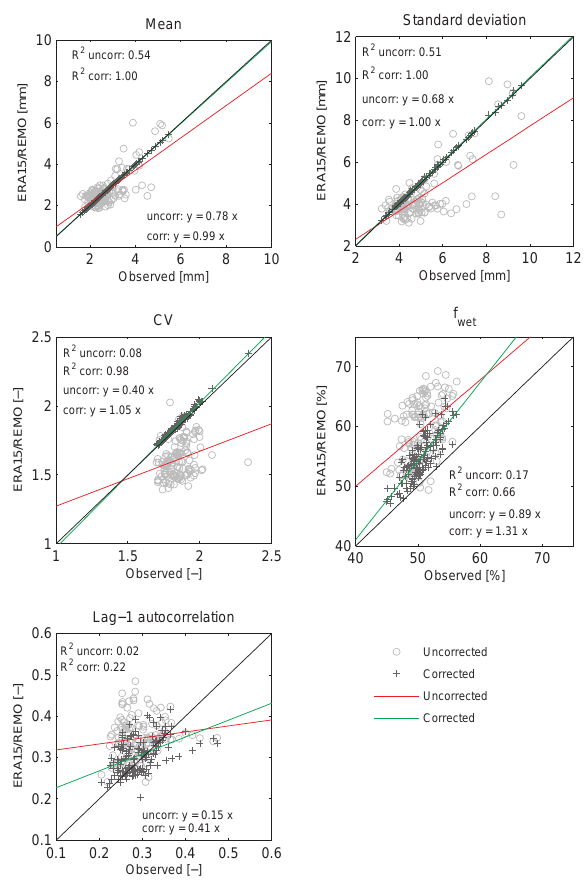
Fig. 7. Scatter plots of the statistics of the observed precipita- tion versus the corrected and uncorrected ERA15/REMO precipi- tation. The statistics are calculated for each sub-basin over the pe- riod 1979–1995. The fraction of wet days ( f wet ) is the percentage of days where P > 0 . 3mm. In each subplot the square of the cor- relation coefficient ( R 2 ) and slope of the linear regression line are plotted. The black line represents the x = y